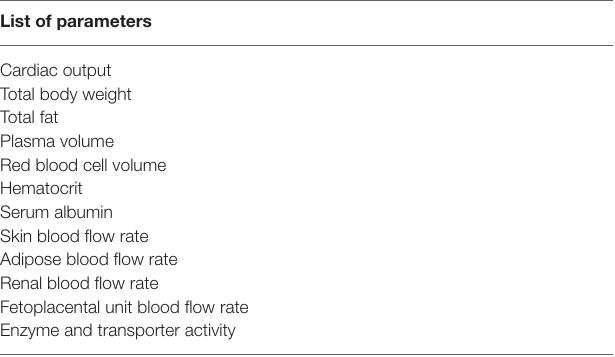
TABLE 4 | Physiological parameters that are modified for pregnancy prediction in Simcyp p-PBPK